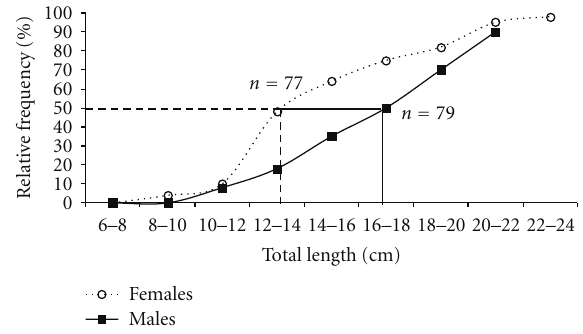
Figure 2: Relative frequency of first gonadal maturation ( L 50 ) of C. menezesi